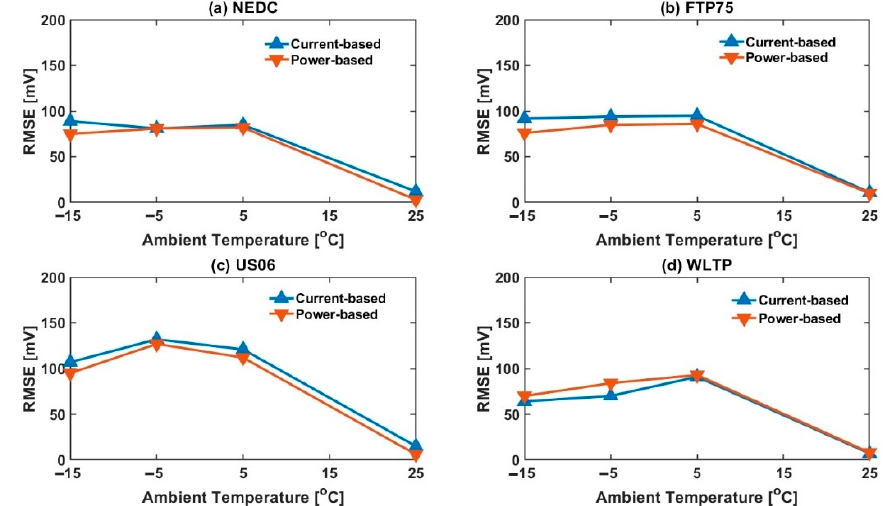
Figure 10. Comparison of model accuracy (RMSE) for current-based (I (t)) and power-based (P (t)) approaches at low ambient temperatures for 65% starting SOC for various legislative drive cycles for ‘2RC’ ECM: ( a ) NEDC, ( b ) FTP75, ( c ) US06 and ( d ) WLTP-3.